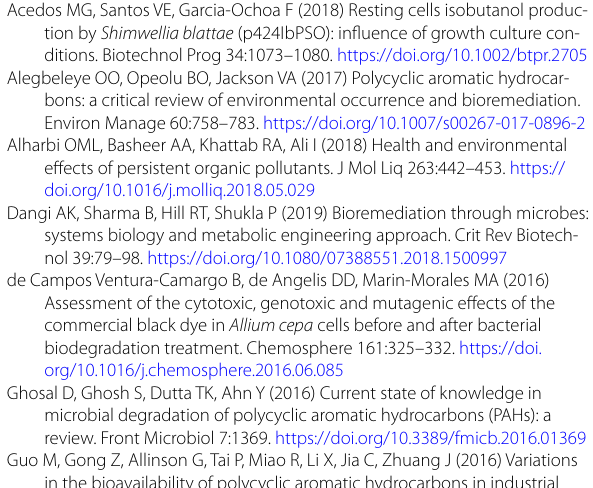
Additional file 1: Figure S1. Combination of cell reusing protocols for the third and fourth